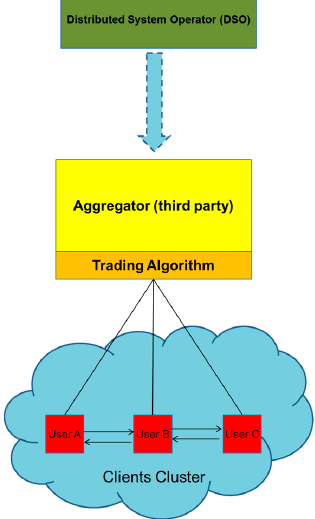
Figure 5. Third party company and relations with DSO and clients.